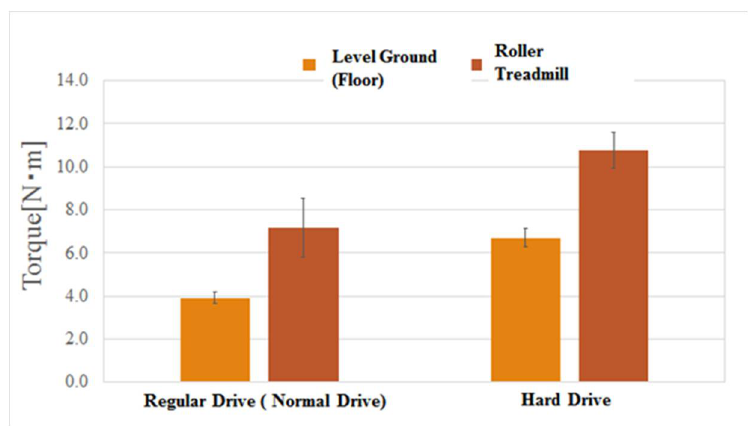
Figure 6. The experiment result of measuring the torque of the DFTA.